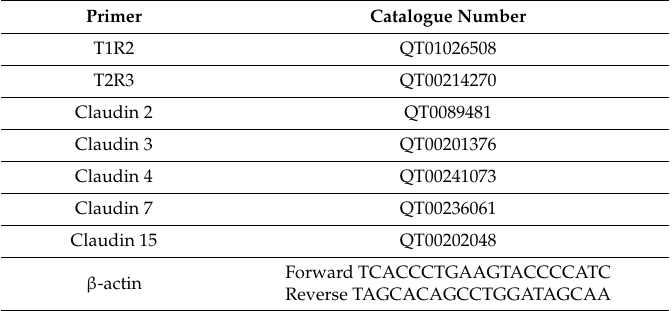
Table 1. List of primers used for Caco-2 cell experiments. Taste receptor and claudin primers were purchased from QIAGEN, while the actin primers were purchased from Sigma-Aldrich.